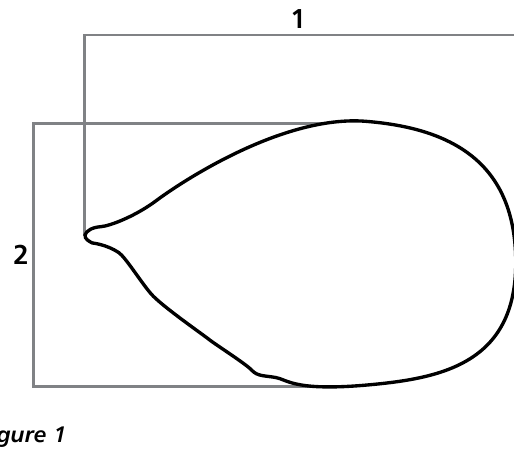
Figure 1 Measured parameters on seed